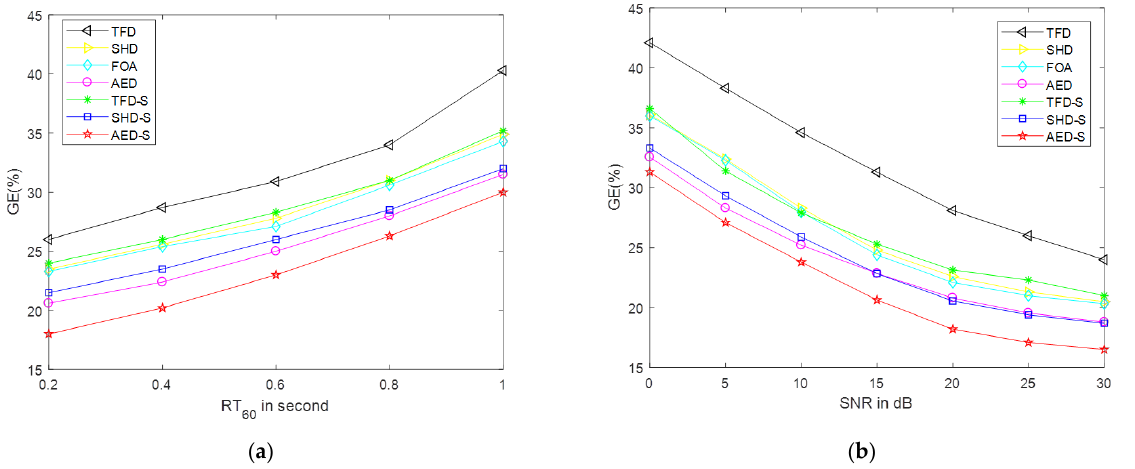
RT . ( b ) is the GE 60